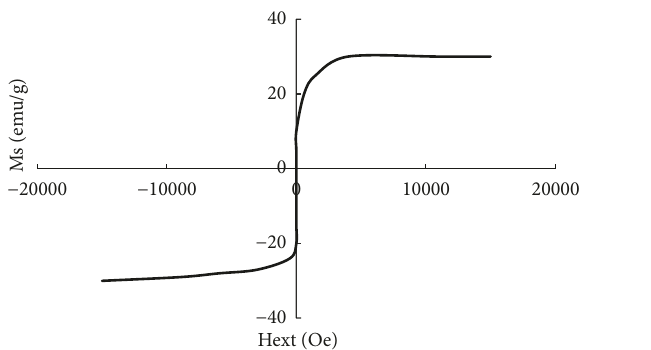
Figure 2: Magnetic response of Fe 2 O 3 -EC.